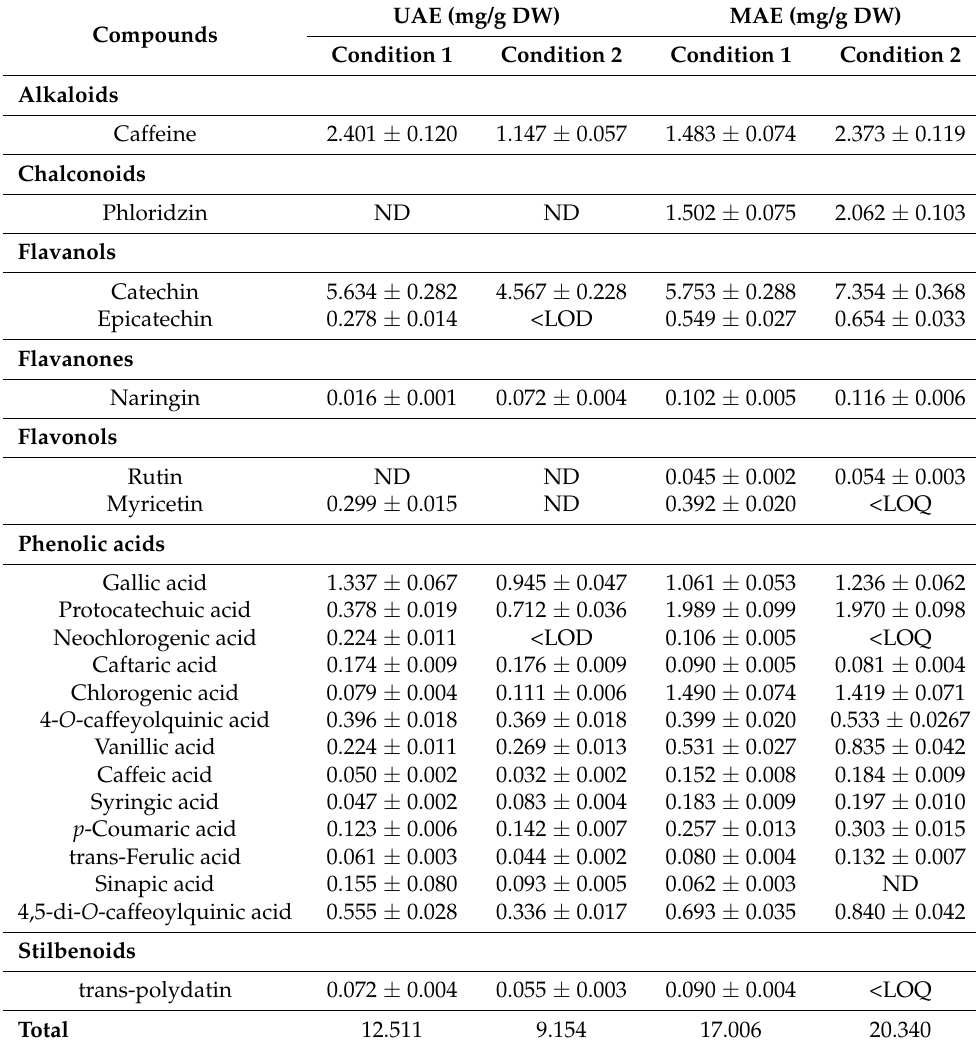
Table 3. Identification and quantification (mg/g DW) of the phenolic compounds present in C. pepo seed extracts obtained by UAE and MAE at different extraction conditions through HPLC–PDA analysis. Results are expressed as mean ± standard deviations ( n =